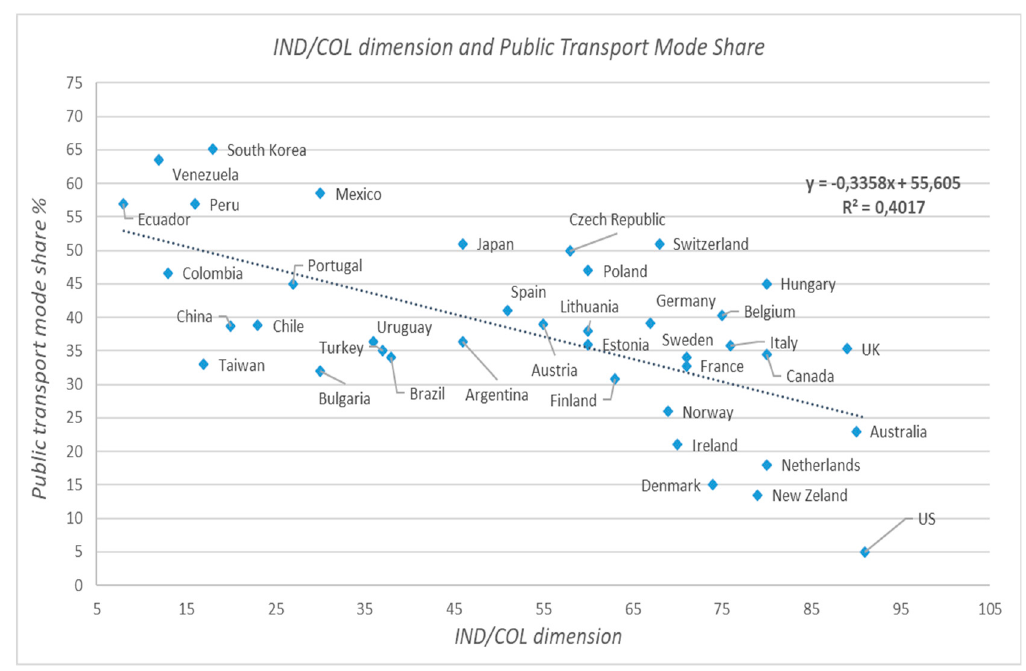
Figure 4. Car ownership over individualism-collectivism dimension.